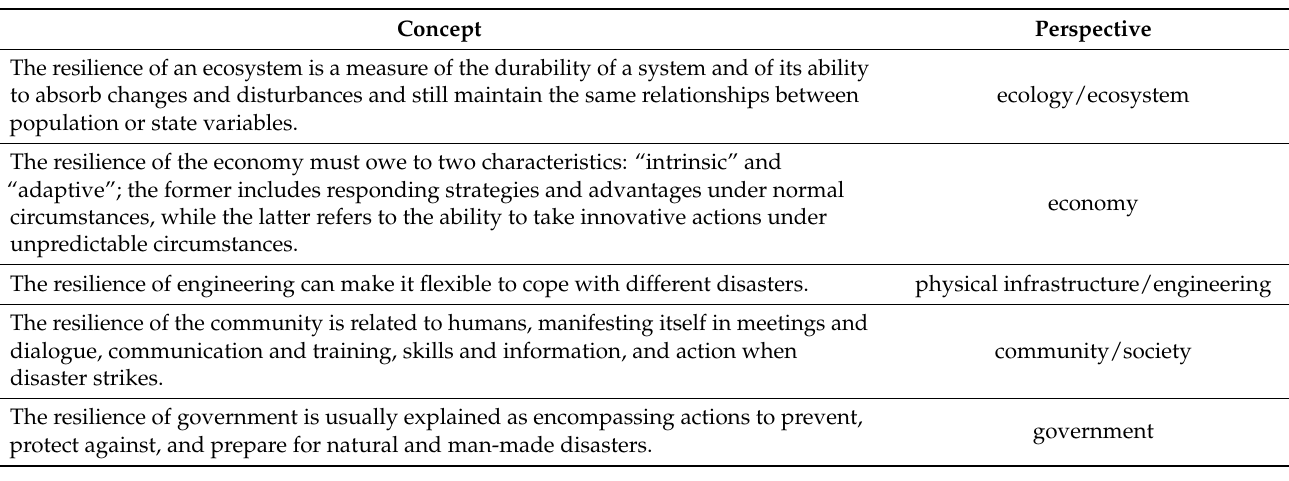
Table 7. Concepts of local infrastructure resilience from different